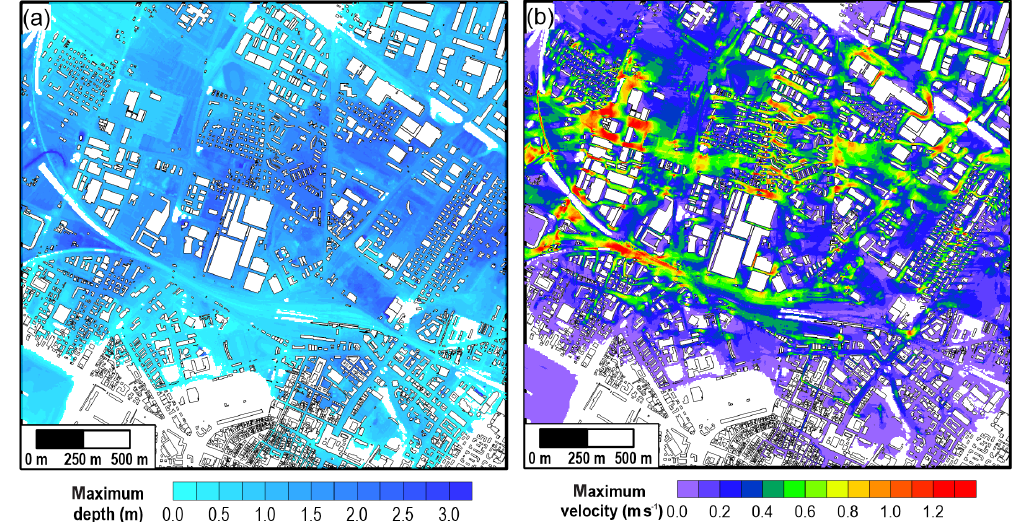
Figure 5. Detail of the complex hydrodynamic field in the city of Modena: maximum water (a) depth and (b) velocity for one breach scenario on the Secchia River.